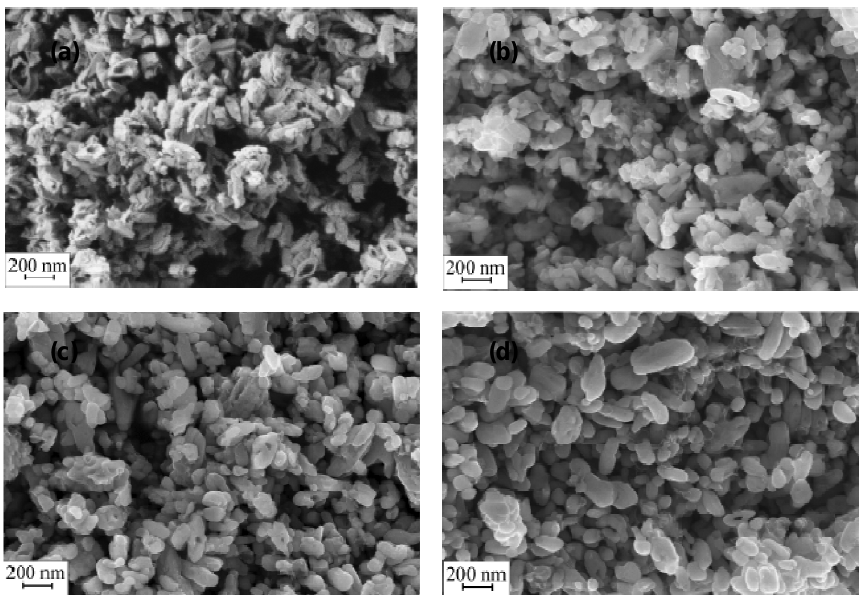
Fig. 3. SEM micrographs of the LFP-{II} (a), LFP/C-sucr-600-{II} (b), LFP/C-PAA-600-{II} (c), LFP/C-PAA- 800-{II}(d)